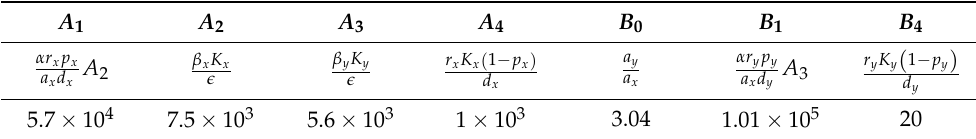
Table 1. The parameters in Equation (6) expressed in terms of the original parameters and their nominal